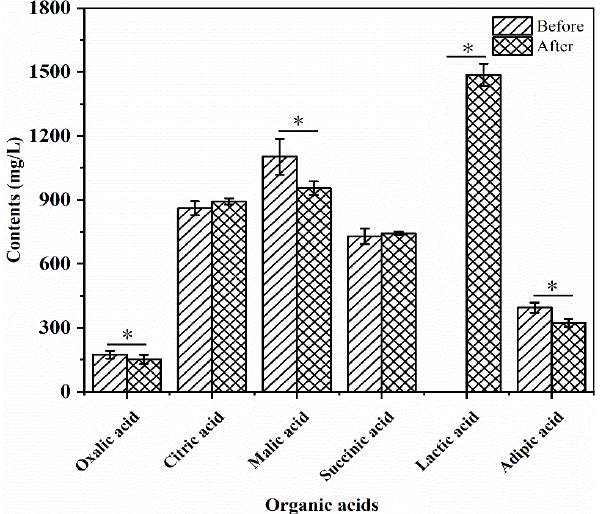
Figure 4. Changes in the content of organic acids before and after fermentation of the R–B mixed juice fermented with L. plantarum TUST-232. Organic acids, including oxalic acid, citric acid, malic acid, succinic acid, lactic acid, and adipic acid, were measured. The error bars indicate means ± SD ( n = 3); the differences between groups were analyzed by a two-tailed paired Student’s t -test. * indicates significant differences at p <